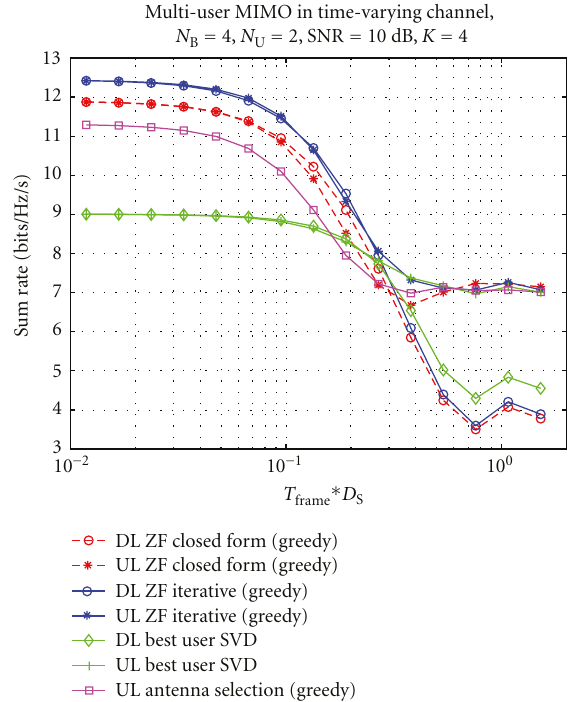
Figure 7: Average sum rate in time-varying channel, with noise-free CSI and ZF receivers, N B = 4, N U = 2, K =